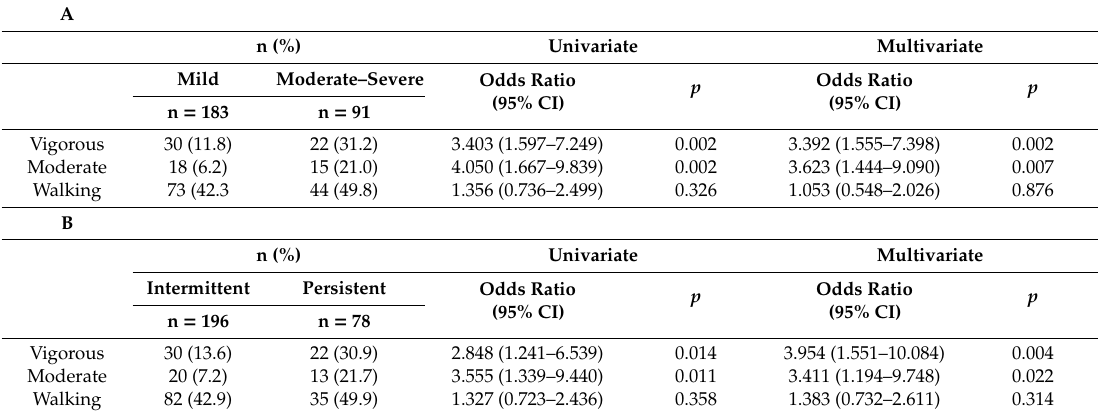
Table 3. Odds ratios for the associations between physical activity and rhinitis (A) severity or (B) persistence in patients with allergic rhinitis.